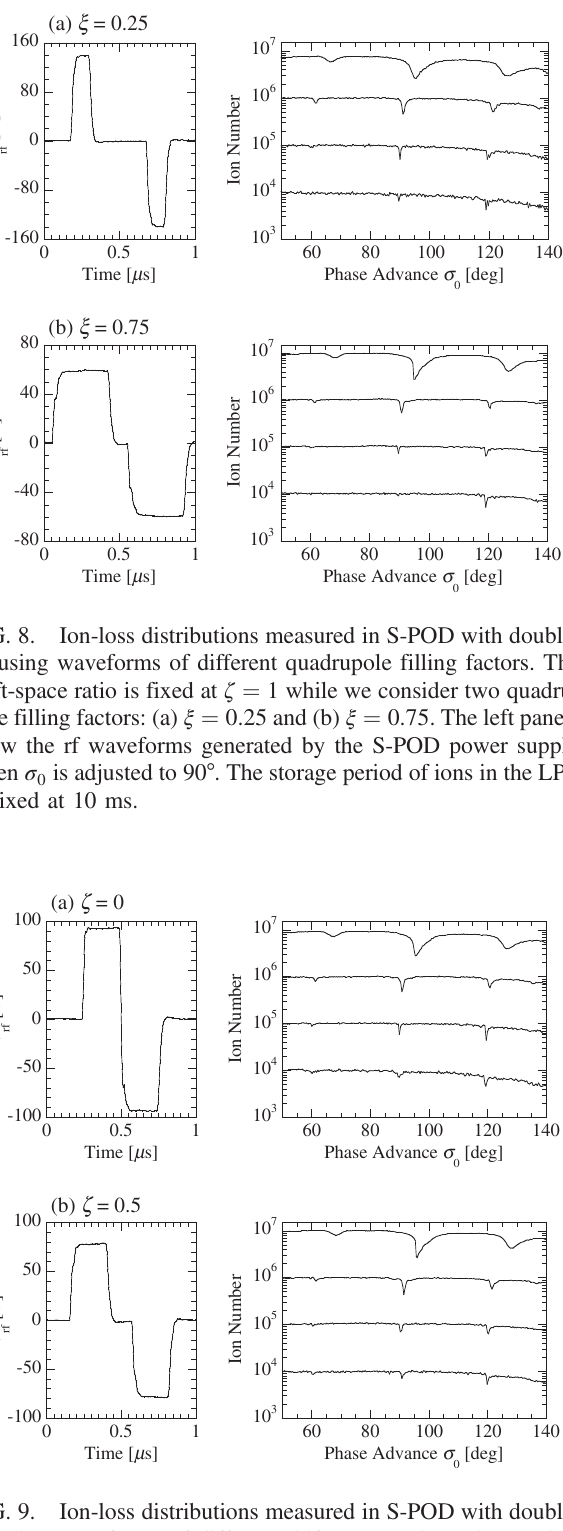
FIG. 9. Ion-loss distributions measured in S-POD with doublet focusing waveforms of different drift-space ratios. The quadru- pole filling factor is fixed at ξ ¼ 0 . 5 while we consider two drift- space ratios: (a) ζ ¼ 0 and (b) ζ ¼ 0 . 5 . The left panels show the rf waveforms generated by the S-POD power supply when σ 0 is adjusted to 90°. The storage period of ions in the LPT is fixed at 10